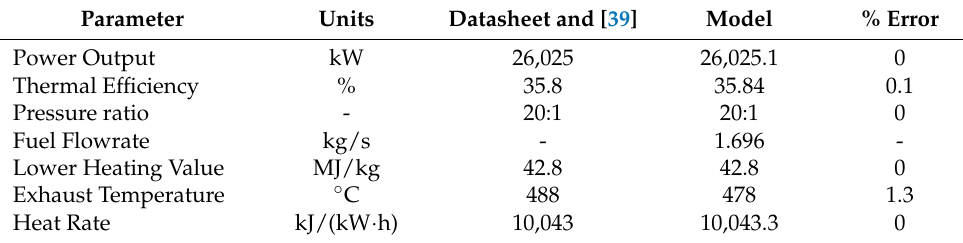
Table 8. The design point model